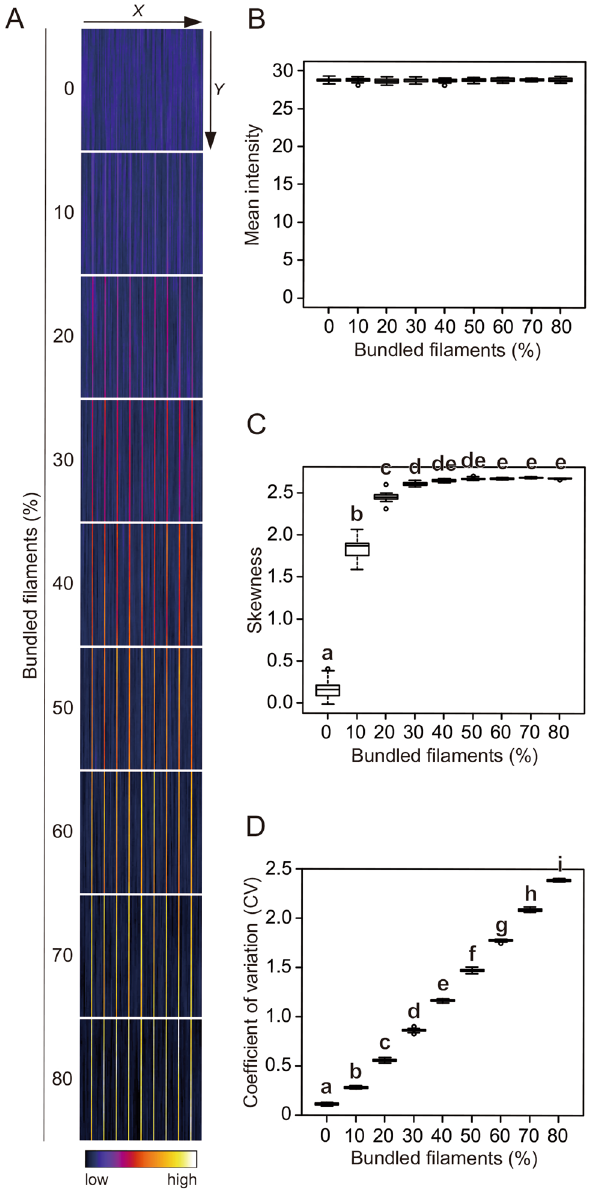
Figure 1. Evaluation of filament bundling in synthetic images. ( A ) Representative synthetic images of virtual cytoskeleton bundling. The images were built by adding filaments with constant intensity and length at random positions. To mimic bundles, the positions of the filaments on the X -coordinate were restricted to 1/20 for different percentages of the filaments (0–80%). ( B ) Mean intensity of the images. ( C ) Skewness of the intensity distribution. ( D ) CV of the intensity distribution. Significance was tested using the Tukey–Kramer test ( P < 0.01). Different lowercase letters indicate significant differences. N =